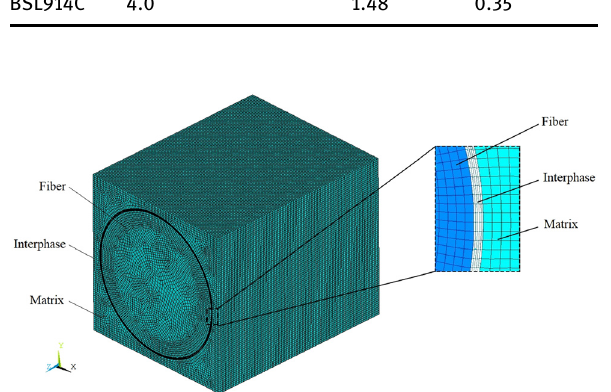
Figure 6: FE Model of RVE with inhomogeneous interphase.